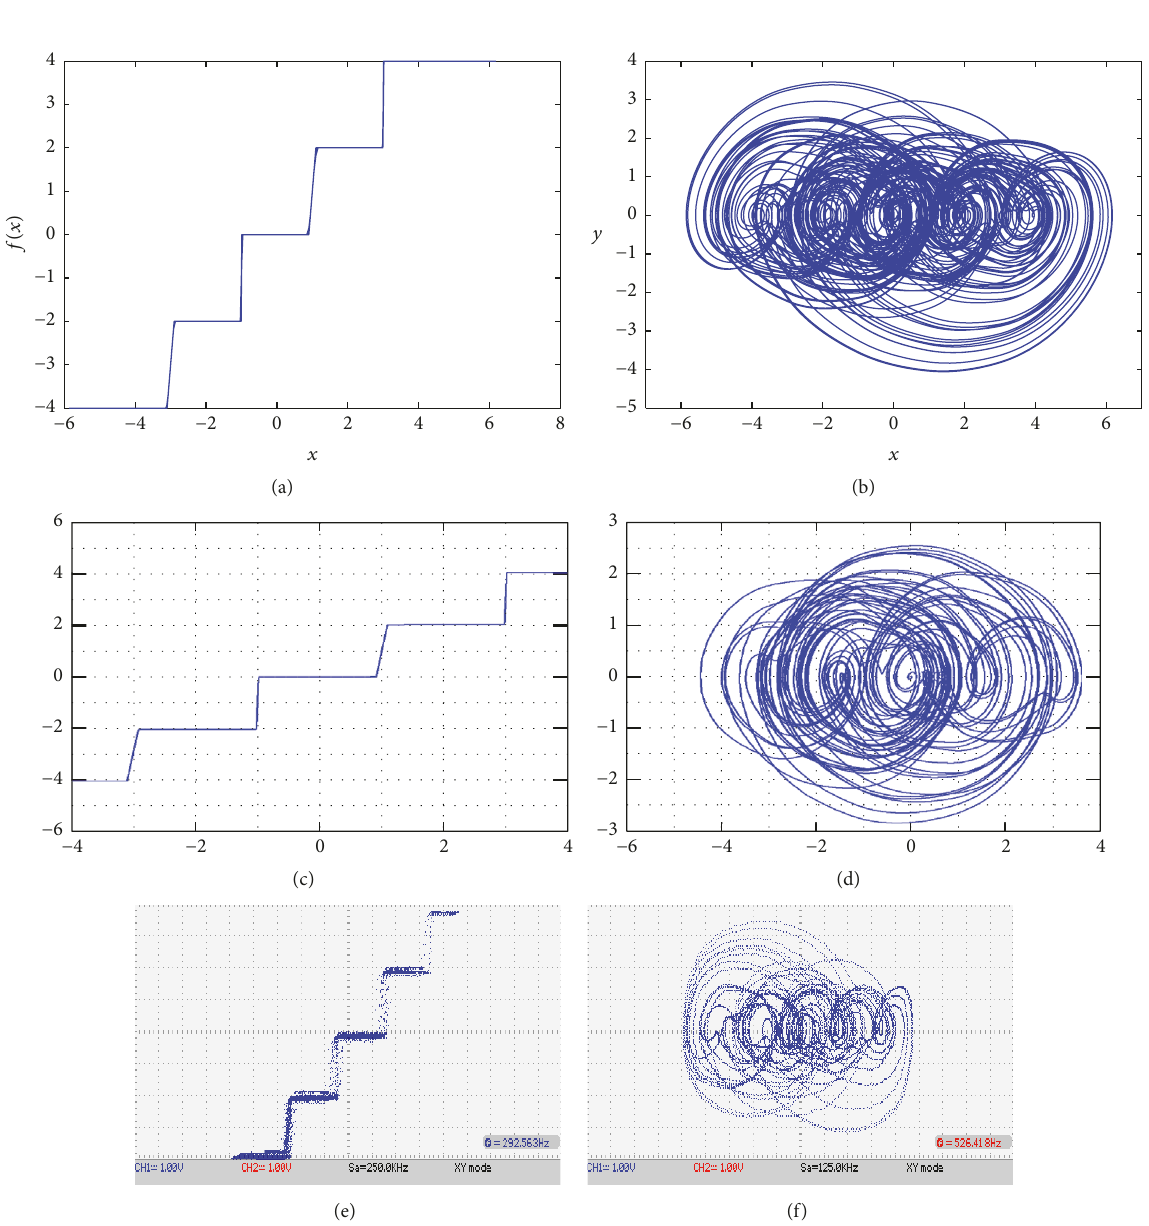
Figure 5: 5-scroll using irregular SNLF for parameters given in Table 2: irregular SNLF and chaotic attractor with (a), (b) MATLAB, (c), (d) SPICE, and (e), (f) experimental